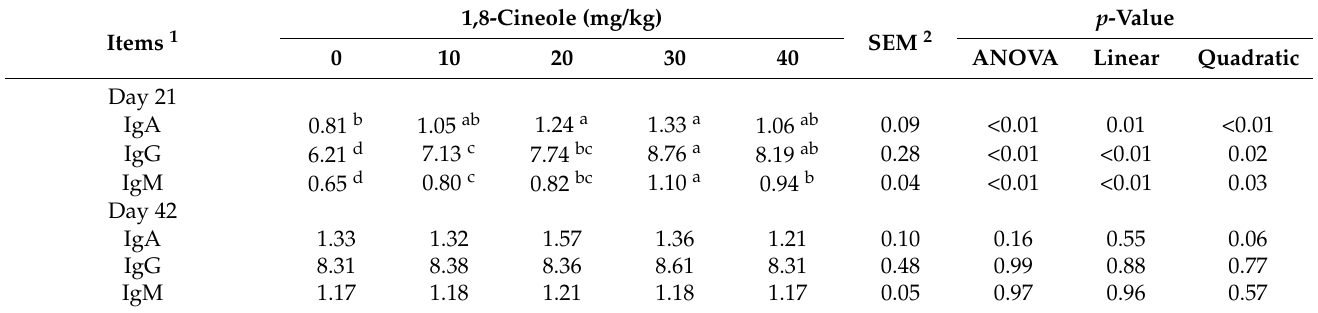
Table 5. Effects of dietary 1,8-cineole inclusion on serum immunoglobulin levels of broiler chick- ens (g/L).